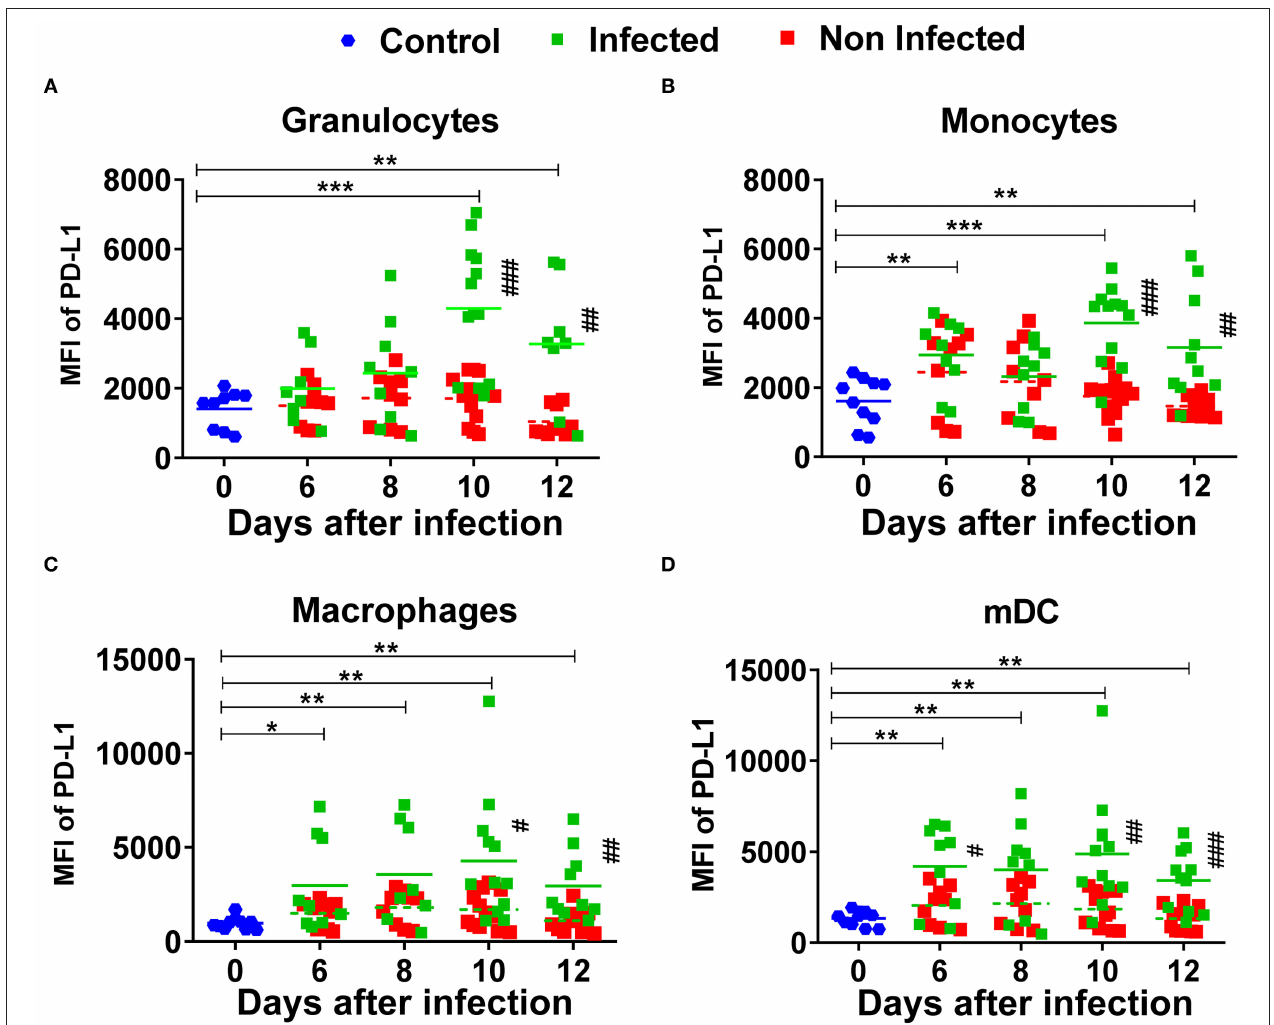
FIGURE 3 | Expression of PD-L1 on myeloid subpopulations after FV infection. C57BL/6 mice were infected with FV-mWasabi and splenocytes were isolated at different time points after infection. Multi-parameter flow cytometry analysis was used to compare the mean fluorescence intensity (MFI) of PD-L1 on the surface of infected (mWasabi + ; green), non-infected (mWasabi − ; red) and naive (day 0; blue) granulocytes (CD11b + Ly6C low Ly6G high ) (A) , monocytes (CD11b + Ly6C high Ly6G low ) (B) , macrophages (CD11b + Ly6G − Ly6C − F4/80 + CD11c low ) (C) , and mDC (CD11b + Ly6C − Ly6G − CD11c + ) (D) . Each dot represents an individual mouse, the mean MFI of PD-L1 are indicated. Data were pooled from three independent experiments with similar results. Differences between 0 and 6, 8, 10, and 12 days were analyzed using one-way ANOVA with a Tukey post-test (* p < 0.05, ** p < 0.005, *** p < 0.0005). Differences between infected and non-infected cells were analyzed using unpaired t -test and are indicated in the figure (# p < 0.05, ## p < 0.005, ### p < 0.0005).